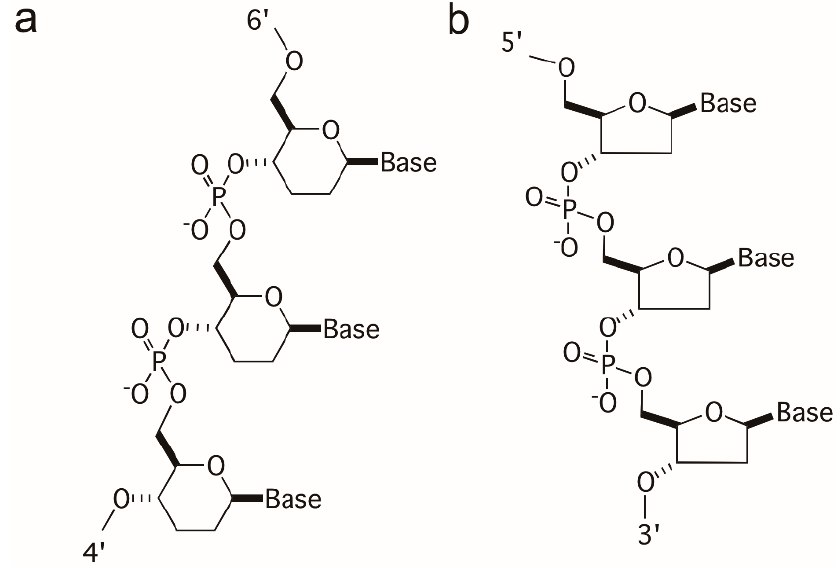
Figure 1. Structures, configurations, and linkage modes of ( a ) homo-DNA ( β -D-2 ′ ,3 ′ - dideoxyglucopyranose sugars) and ( b ) DNA. Strand polarities are indicated by numbers and the backbone conformation for both can be described with six torsion angles α to ζ .